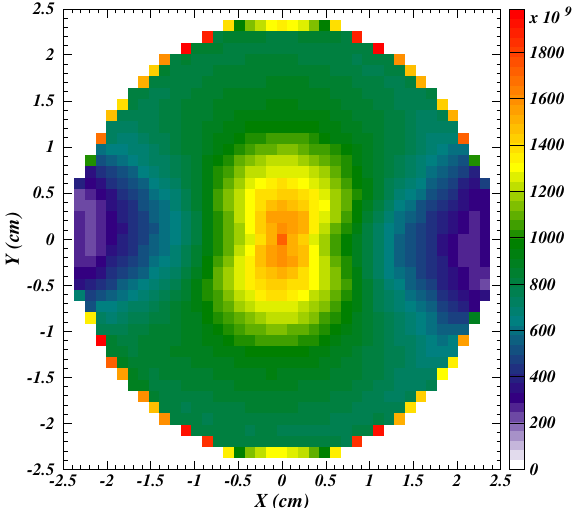
FIG. 13. Simulated EC density profile averaged over the 4 . 5 μ s simulation time in a fieldfree region of arc region 1 without application of the solenoidal magnetic field mitigation technique.